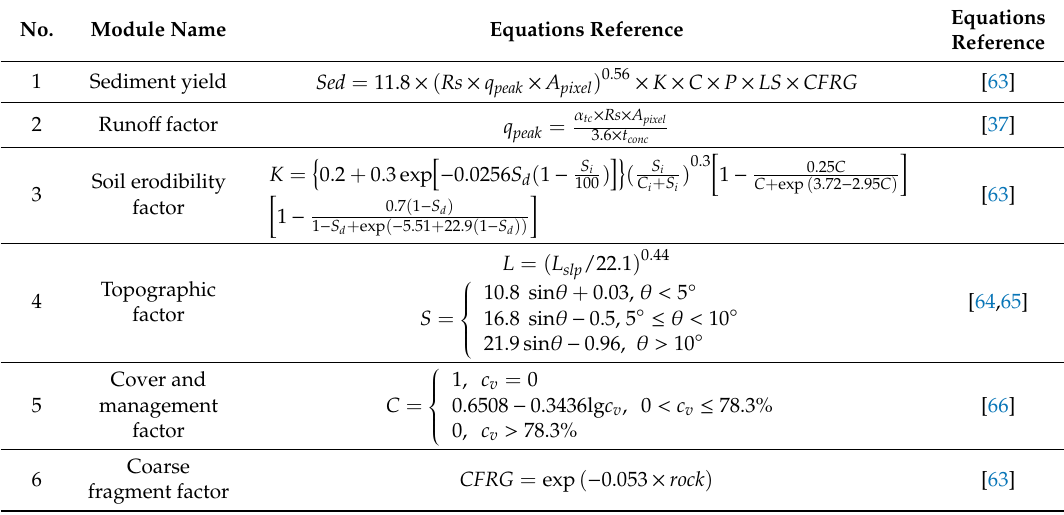
Table 2. Functions and parameters related to sediment yield in the Land Catchment Model-Modified Universal Soil Loss Equation (LCM-MUSLE)